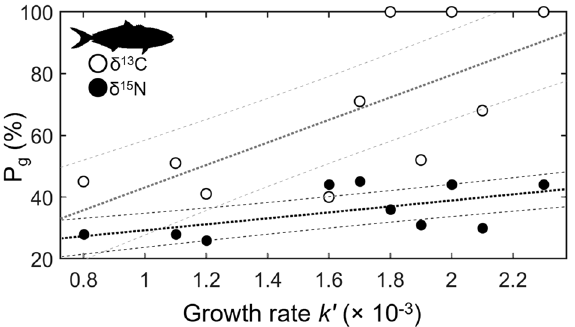
Figure 5. Proportion of isotopic turnover in muscle due to growth (P g ) increases with growth rate in yellowtail Seriola dorsalis. Points represent individual measurements of δ 15 N (filled circles) and δ 13 C (open circles) and lines show associated linear fits (dark dashed lines) and 95% confidence intervals (light dashed lines). Positive relationships were significant between P g and k ʹ for both δ 13 C (linear regression, P = 0.03) and δ 15 N (linear regression, P =